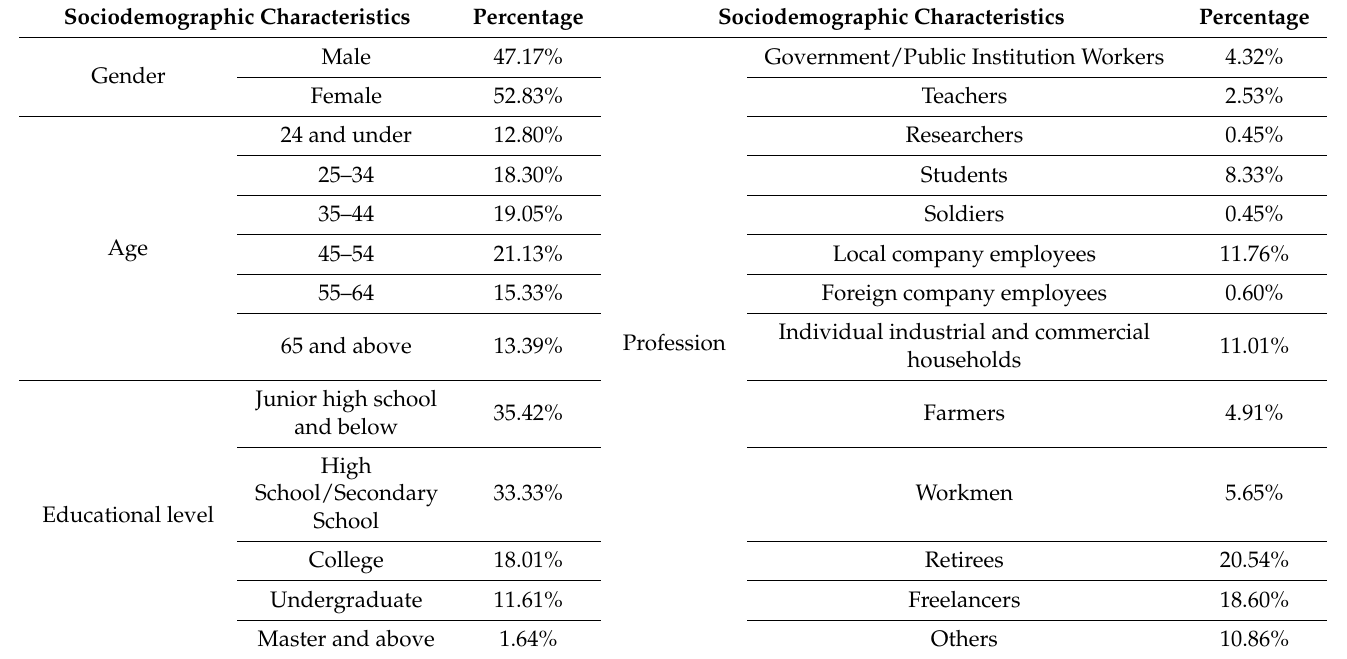
Table 4. Statistics on the socio-demographic characteristics of the